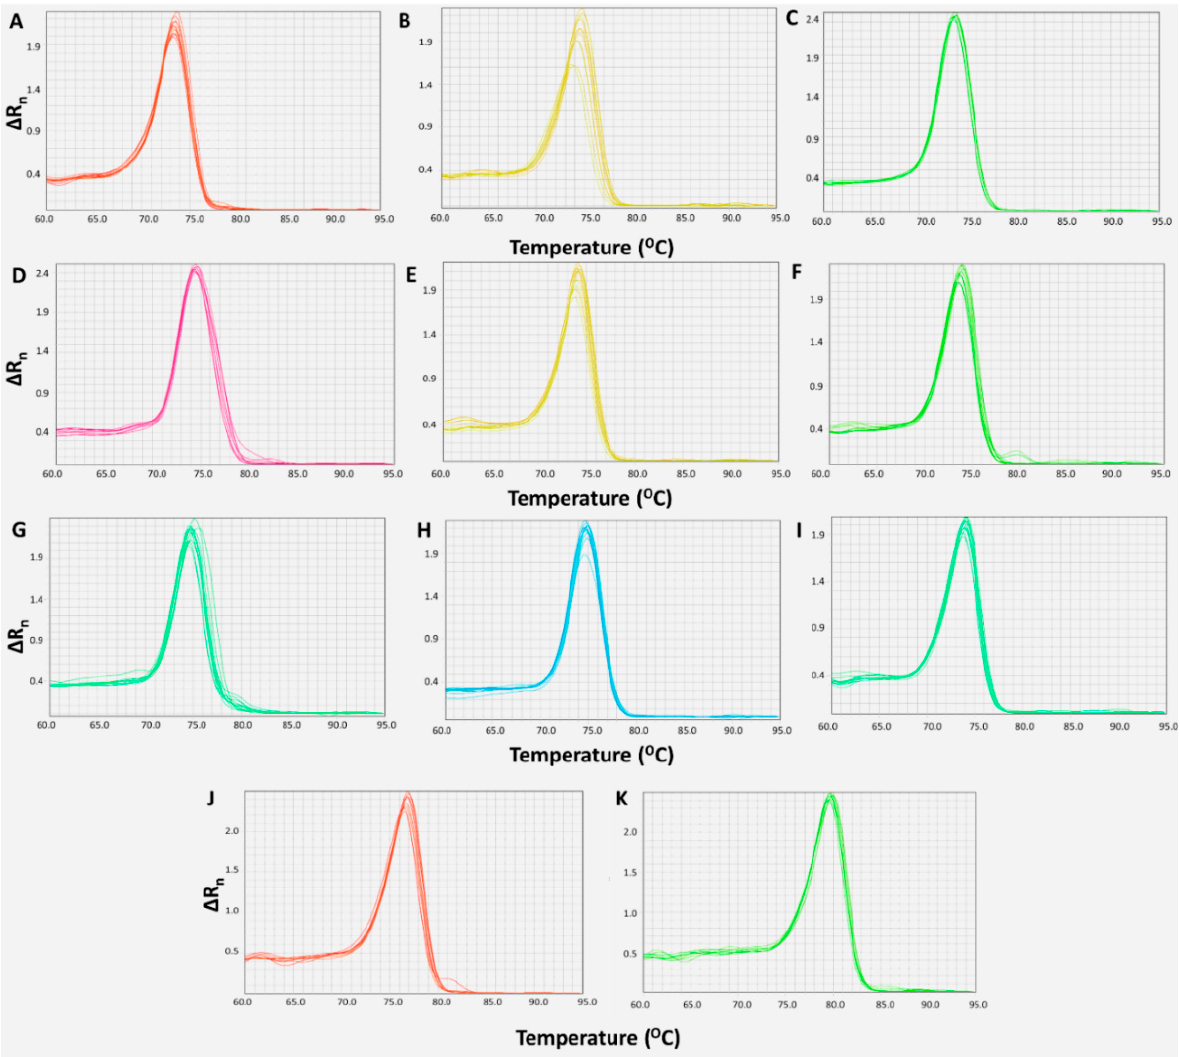
Figure 1. Melting curves of miR-15a-5p ( A ), miR-16-5p ( B ), miR-21-5p ( C ), miR-25-3p ( D ), miR-125b-5p ( E ), miR-155-5p ( F ), miR-221-3p ( G ), miR-222-3p ( H ), miR-223-3p ( I ), SNORD43 ( J ), and SNORD48 ( K ), generated after their amplification under the optimized conditions of the real-time quantitative PCR (qPCR) assays. The graphs were built by plotting Δ Rn, which represents the difference in the fluorescence from the baseline, against temperature.